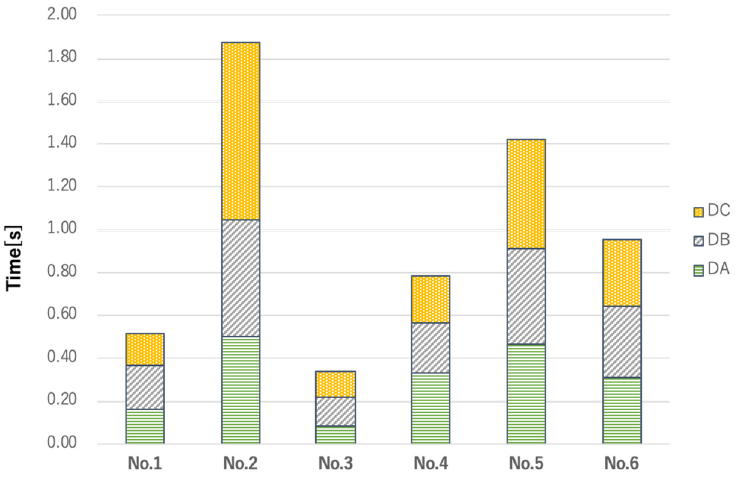
Figure 5. Sum of errors in sensor measurements vs VF measurements. The sum of sensor error (DA + DB + DC) versus VF for each subject is graphed from the results in Table 1. The smallest errors in the VF and sensor readings were observed in No. 3, with errors of DA: 0.09 ± 0.07 s, DB: 0.13 ± 0.07 s and DC: 0.12 ± 0.04 s. The largest errors were seen for subject No. 2, with DA: 0.50 ± 0.15 s, DB: 0.54 ± 0.12 s and DC: 0.83 ± 0.30 s. DA: Difference in the time of emergence of VA and SA; DB: Difference in the time of emergence between VB and SB; DC: Difference in the time of emergence of VC between SC; VF: Videofluroscopy. Table 1. Results of the measurements for each subject.